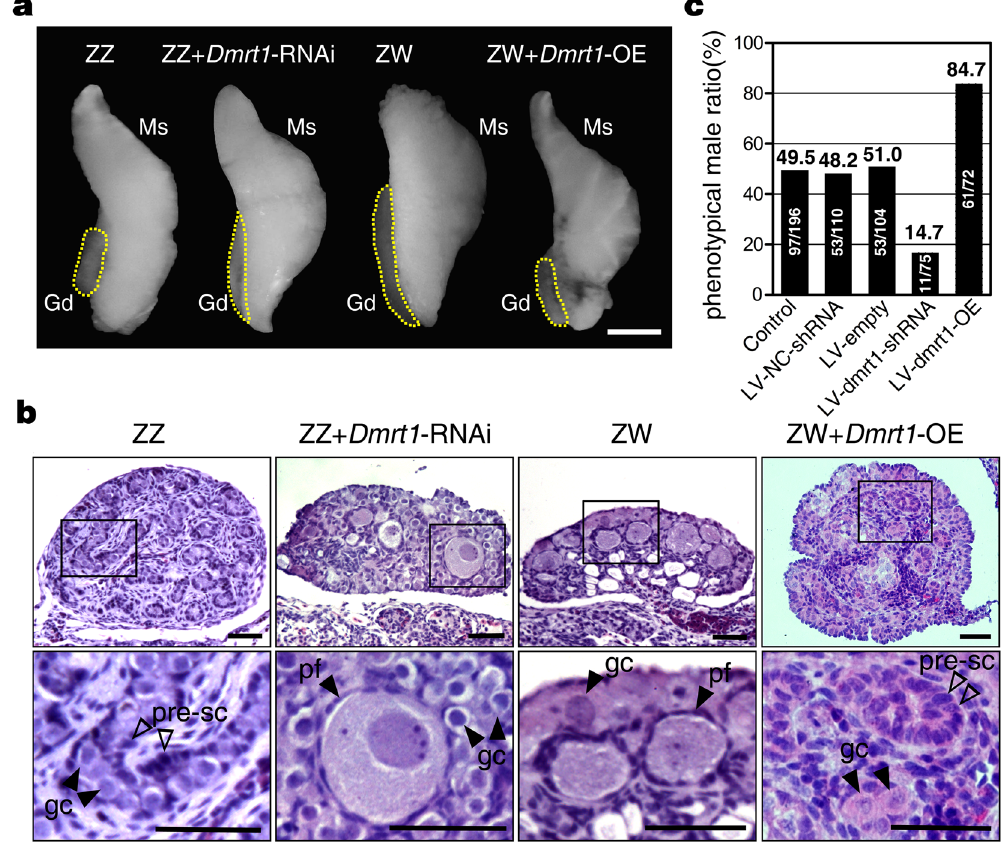
Figure 5. Effects of Dmrt1 knockdown or over-expression on gonadal differentiation. ( a ) At stage 27, the ZZ gonads with Dmrt1 knockdown became elongated and flat, compared to the control ZZ gonads. The ZW gonads overexpressing Dmrt1 appeared distinctly short, similar to control ZZ gonads. Gd, gonad; Ms, mesonephros. Scale bar is 1 mm. ( b ) The H&E stain showed that thickened outer cortex with primordial follicles and degenerated testis cord were observed in the ZZ gonads with Dmrt1 knockdown, however, the ZW gonads overexpressing Dmrt1 exhibited a well developed medullary region with seminiferous cord-like structure. pre-sc, precursor sertoli cell; gc, germ cells; pf, primordial follicle. Scale bars are 50 μ m. ( c ) The phenotypical male ratio of control embryos, scrambled control embryos with LV-NC-shRNA or LV-empty and embryos treated with LV- Dmrt1 -shRNA or LV- Dmrt1